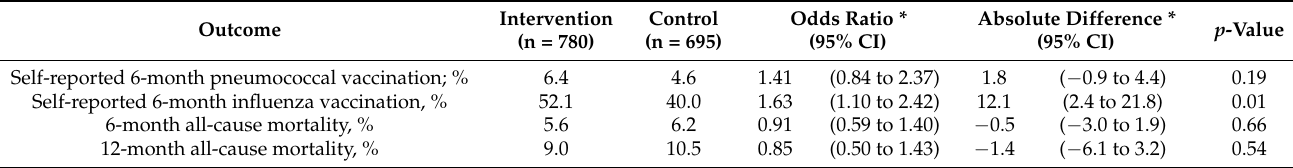
Table 3. Comparison of primary and secondary outcomes in intention-to-treat analysis; IMPROVED trial (N = 1475).